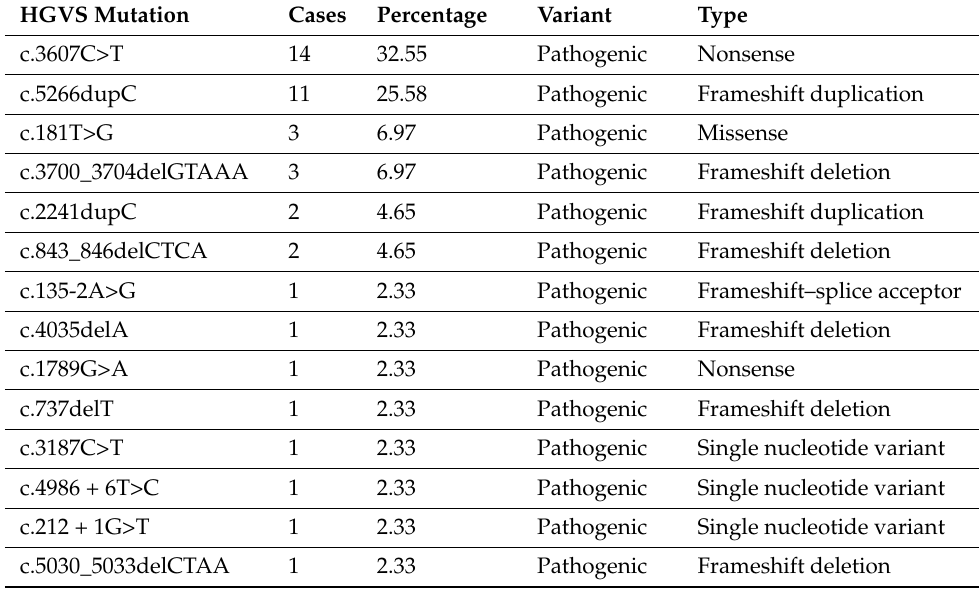
Table 2. Pathogenic BRCA 1 variants identified in the study group patients.